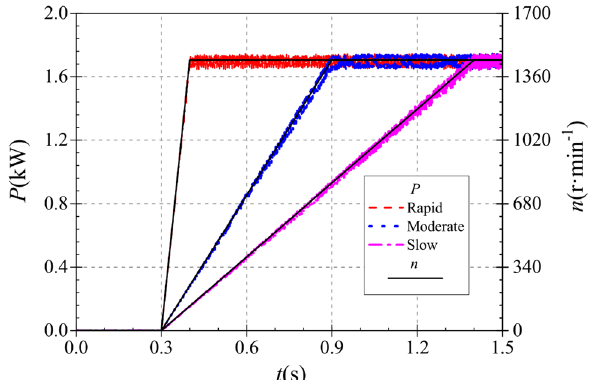
Figure 9. Instantaneous shaft power rise characteristics.